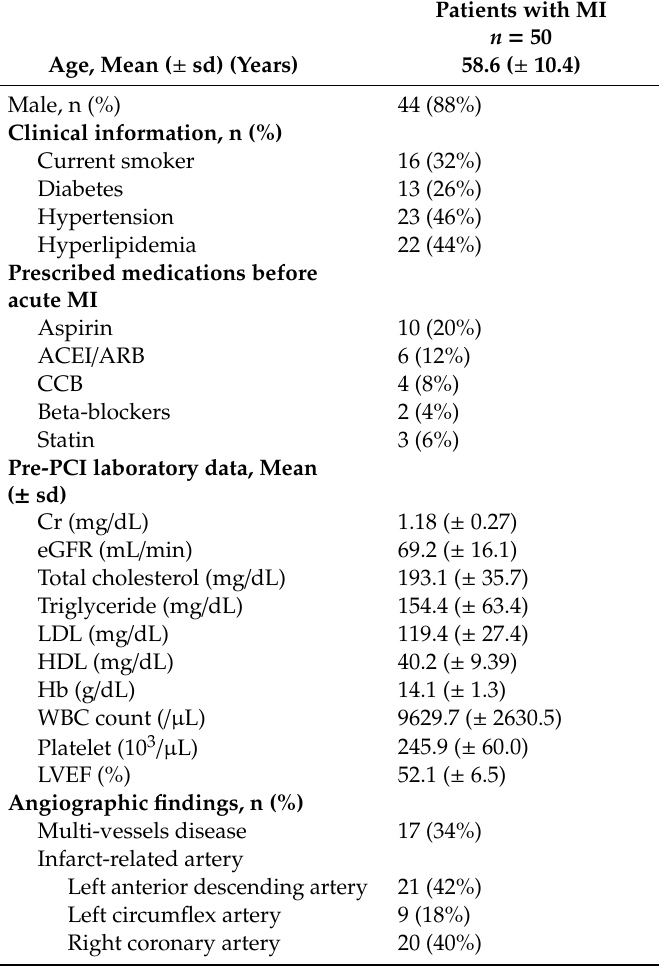
Table 1. Baseline clinical characteristics of patients with MI receiving successful reperfusion